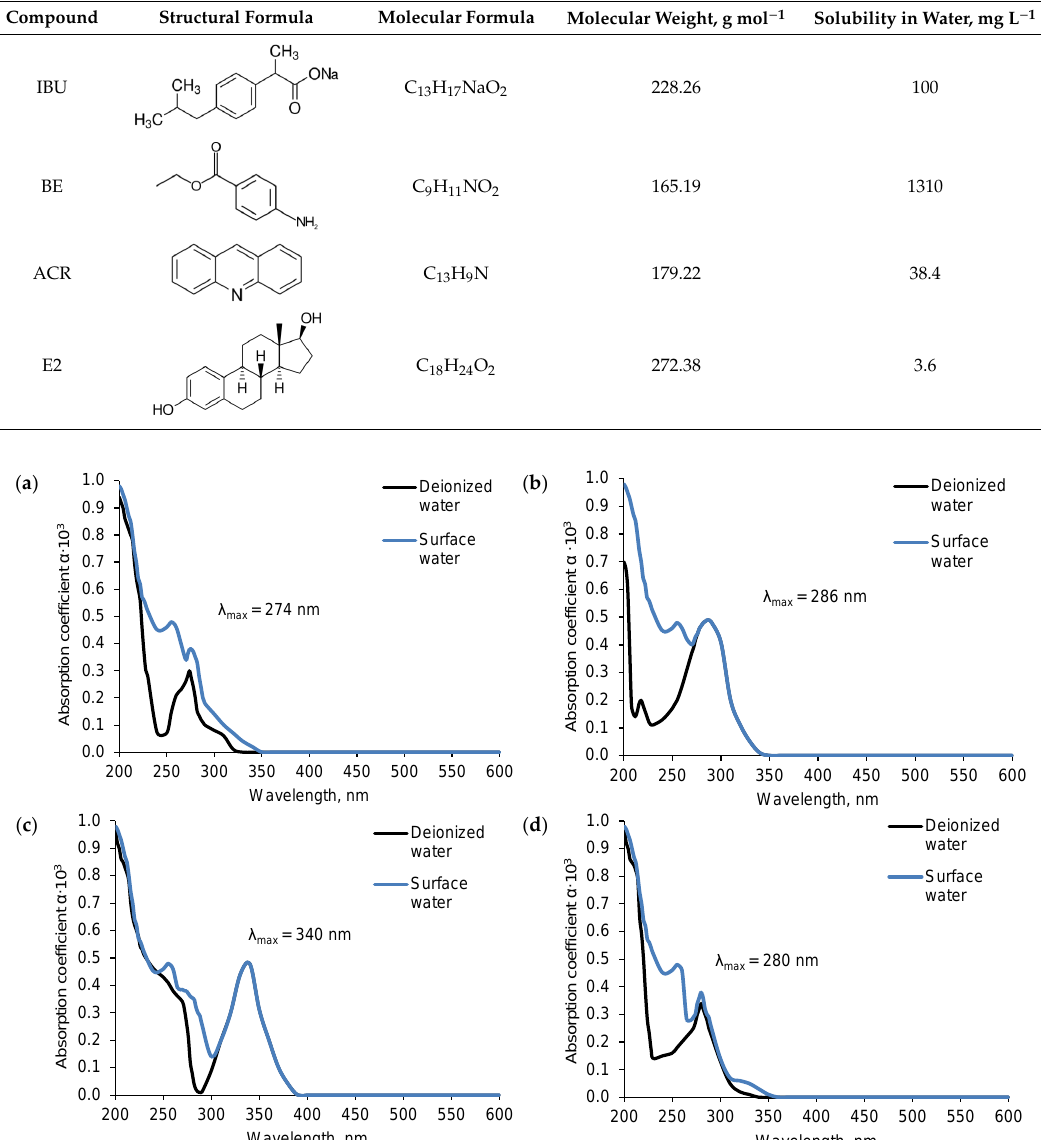
Table 3. Characteristics of the tested organic compounds [43].